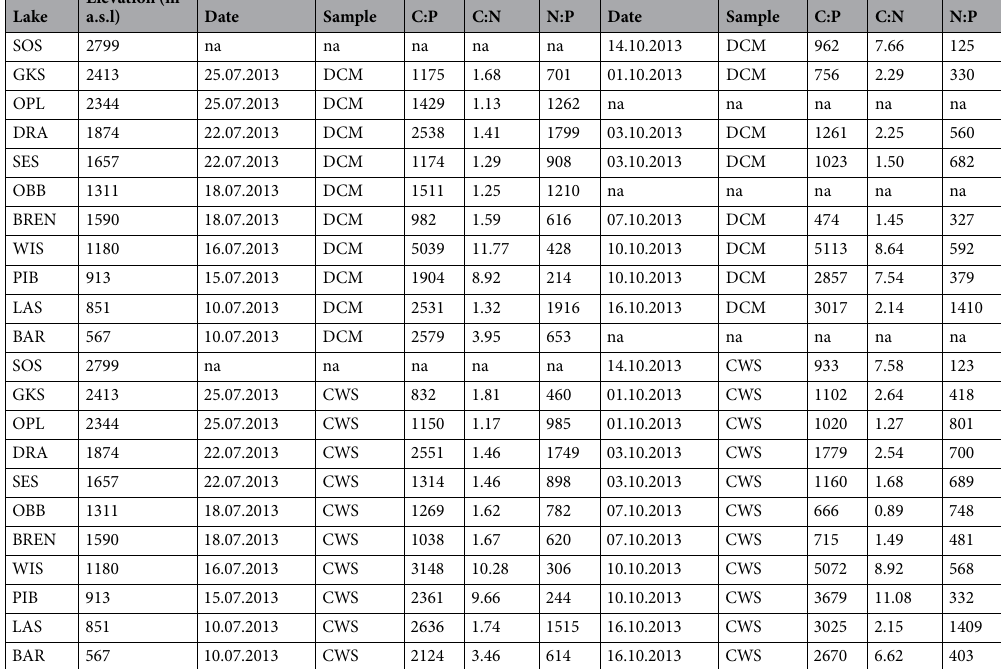
Table 1. Summary of the stoichiometry of the dissolved fraction in composite water samples (CWS) and in samples from the deep chlorophyll-a maximum (DCM). C:P, C:N, N:P are mean molar ratios. BAR: Baggersee Rossau, LAS: Lansersee, PIB: Piburgersee, WIS: Wildsee bei Seefeld, BREN: Brennersee, OBB: Obernbergersee, SES: Sebensee, DRA: Drachensee, OPL: Oberer Plenderlesee, GKS: Gossenköllesee, SOS: Schwarzsee ob Sölden. na: data not